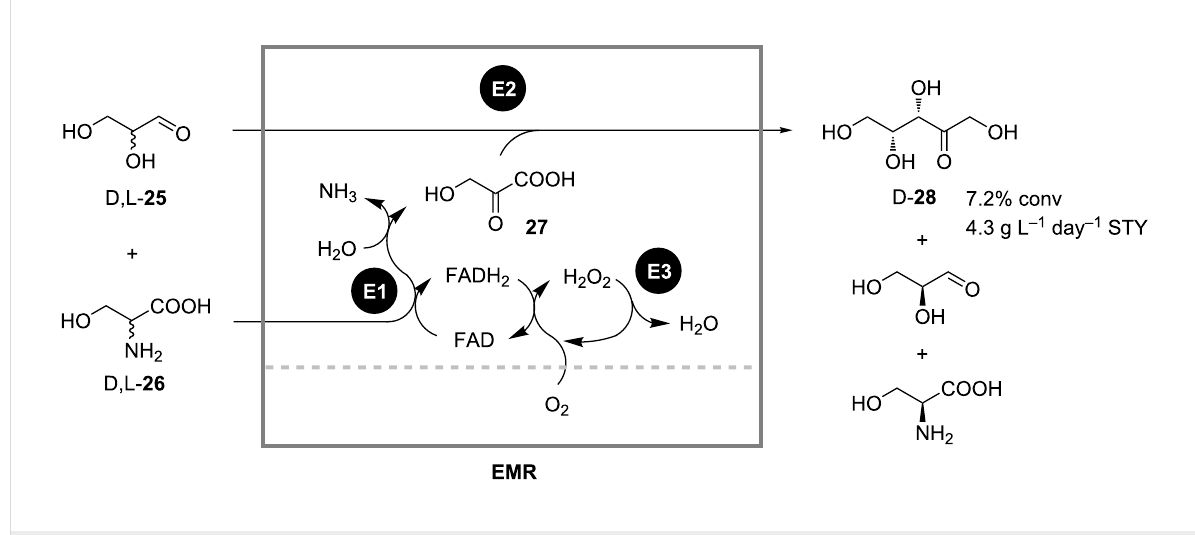
Scheme 9: Synthesis of D-xylulose ( 28 ) from D,L-serine ( 26 ) and D,L-glyceraldehyde ( 25 ) in a continuously operated enzyme membrane reactor. E1: D-Amino acid oxidase; E2: Transketolase; E3: Catalase [32].